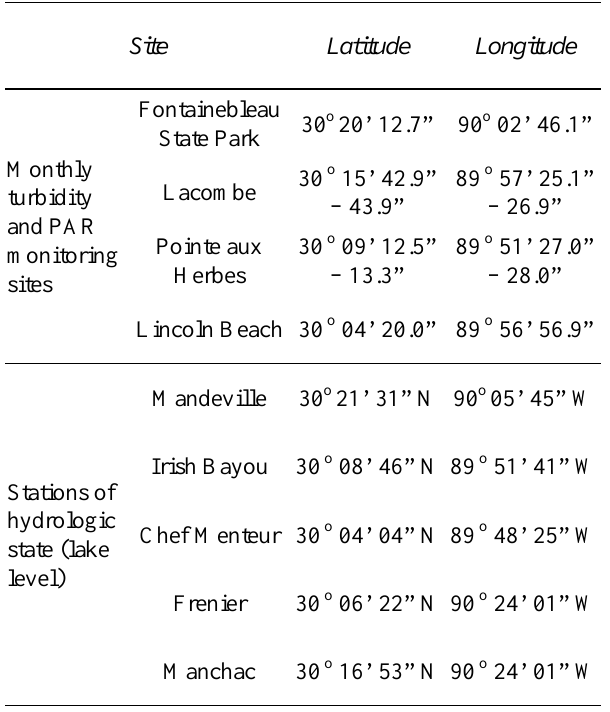
Table 1: Geographic coordinates for turbidity-PAR monitoring sites and the stations for the hydrologic